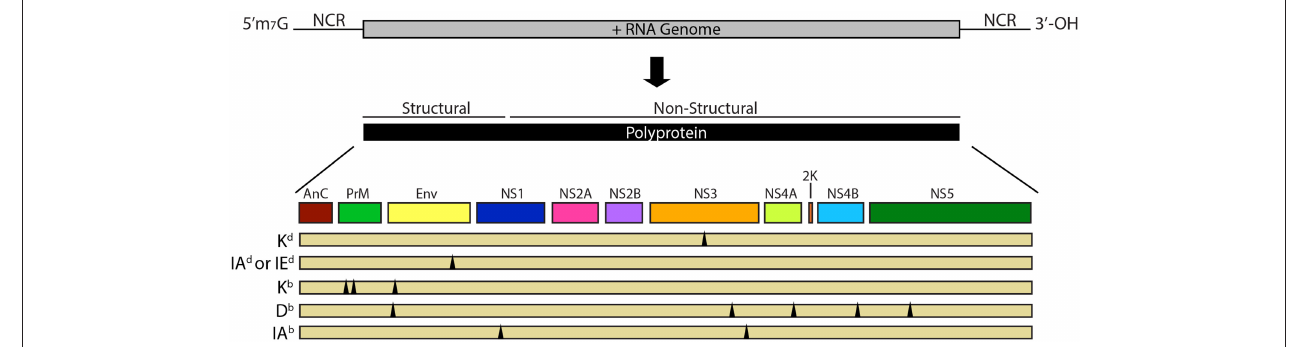
FIGURE 1 | Flavivirus genome and proteins. The flavivirus genome consists of a single positive-stranded RNA molecule with a 5 ′ methylguanosine cap followed by an untranslated region (UTR), open reading frame (ORF) and a 3 ′ UTR with multiple variable stem loop structures. The genome is translated from a single ORF into a polyprotein that is proteolytically cleaved by both viral and host proteases. The genome codes for three structural proteins (capsid, membrane, and envelope) and seven non-structural proteins (NS1, NS2a, NS2b, NS3, NS4a, NS4b, and NS5). Theoretically, peptides of any of these structural or non-structural proteins have the potential to be targets of the virus-specific T cell response. Multiple flavivirus cross-reactive T cell epitopes with murine MHC restriction have been demonstrated in various murine models, the breadth of which are indicated by the triangles below the polyprotein. For detailed information on these identified cross-reactive epitopes see Table 2